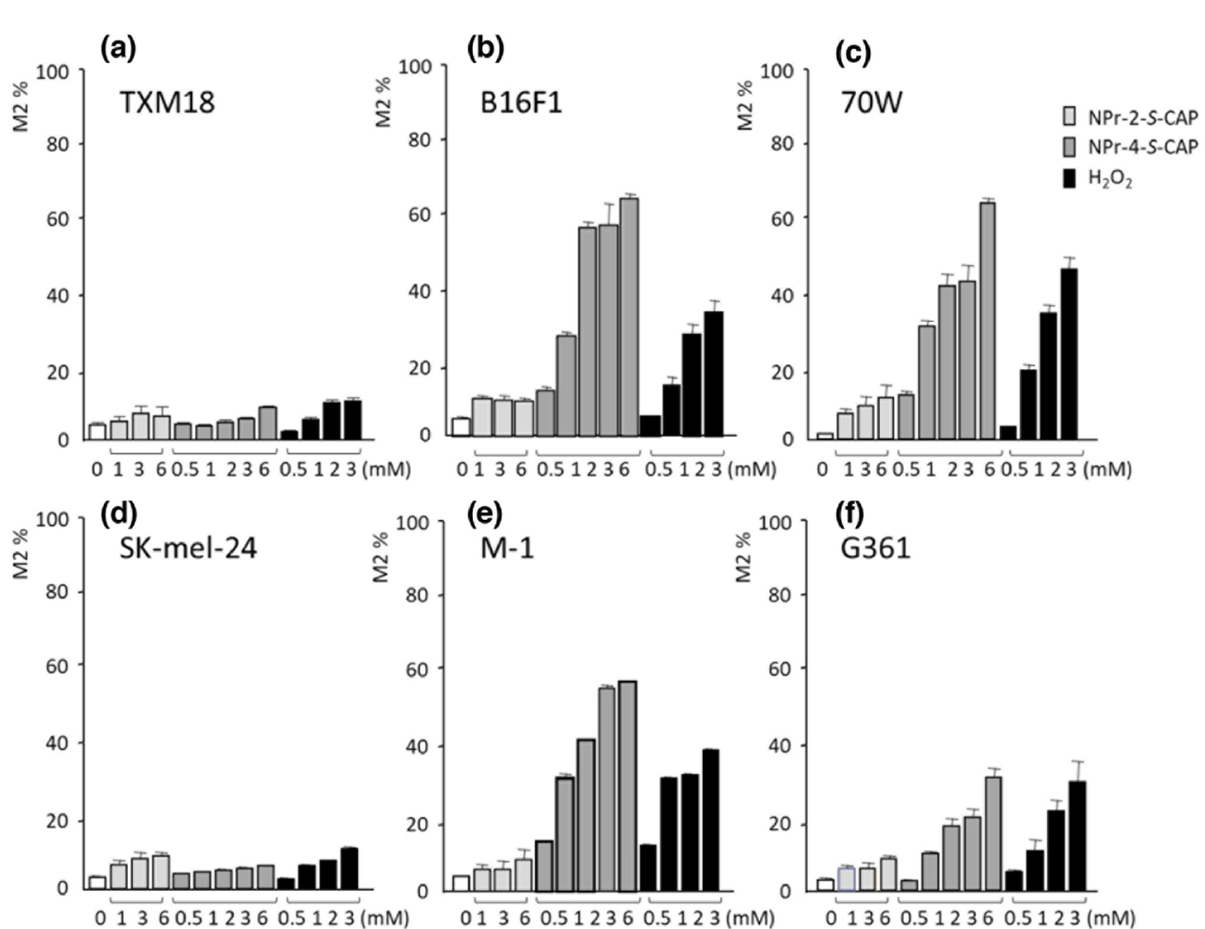
Figure 14. Pigmented but not non-pigmented melanoma cells produce ROS in the presence of NPr-4- S